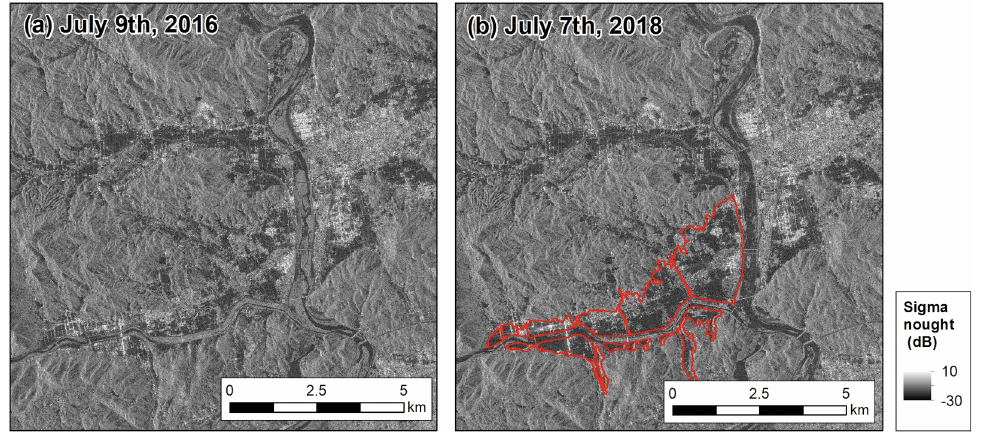
Figure 2. ALOS–2/PALSAR–2 data: ( a ) Pre-event ALOS–2/PALSAR–2 data observed on 9 July 2016 and ( b ) post-event ALOS–2/PALSAR–2 data observed on 7 July 2018. The red line in ( b ) is the boundary of the flooded area as reported by the Geospatial Authority of Japan